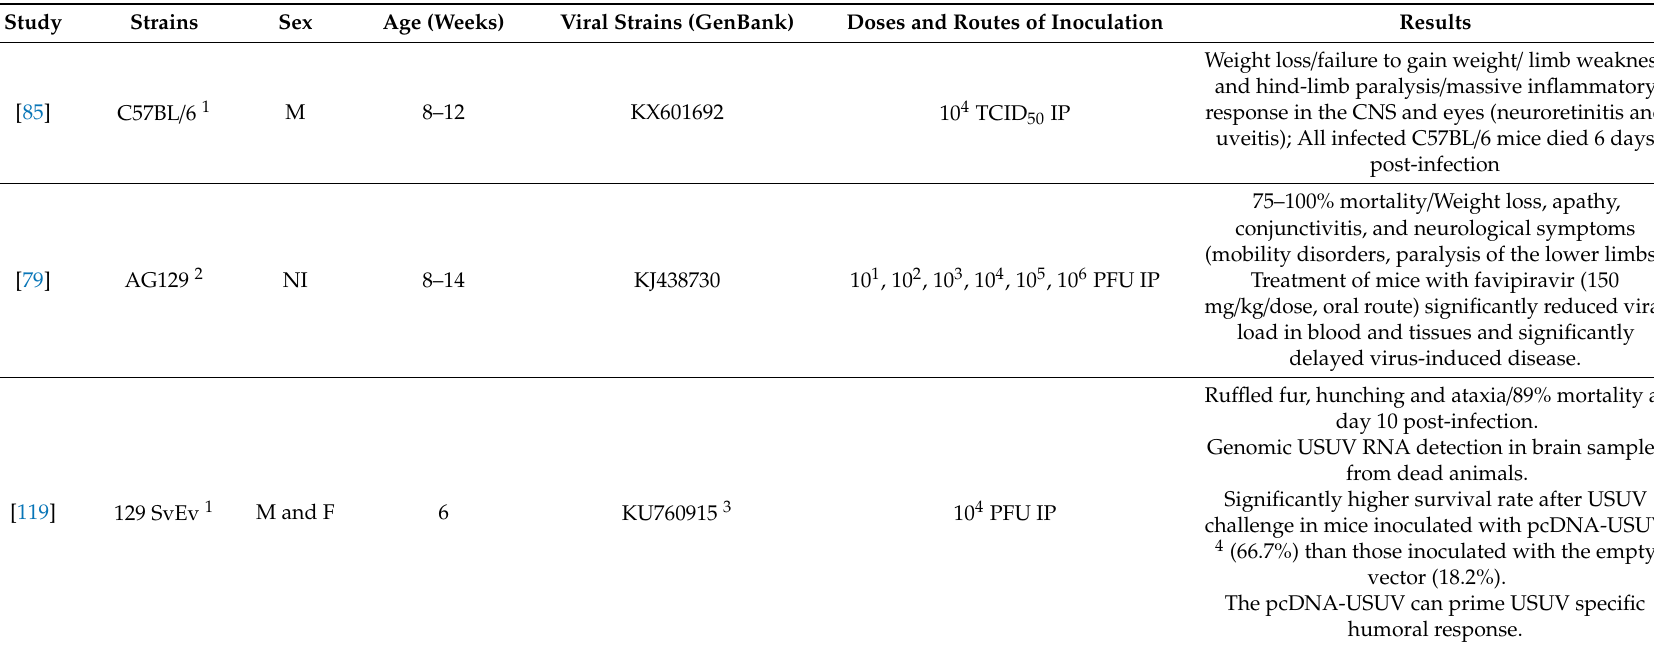
Table 6. Immunocompromised mouse models for studying USUV